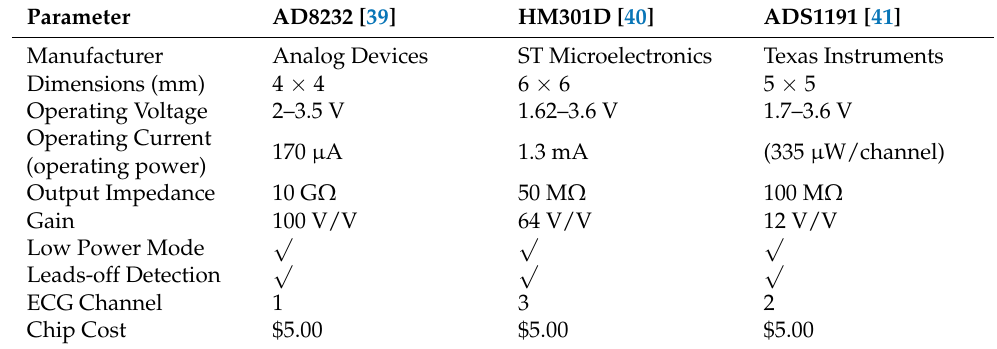
√ means that the feature is available).